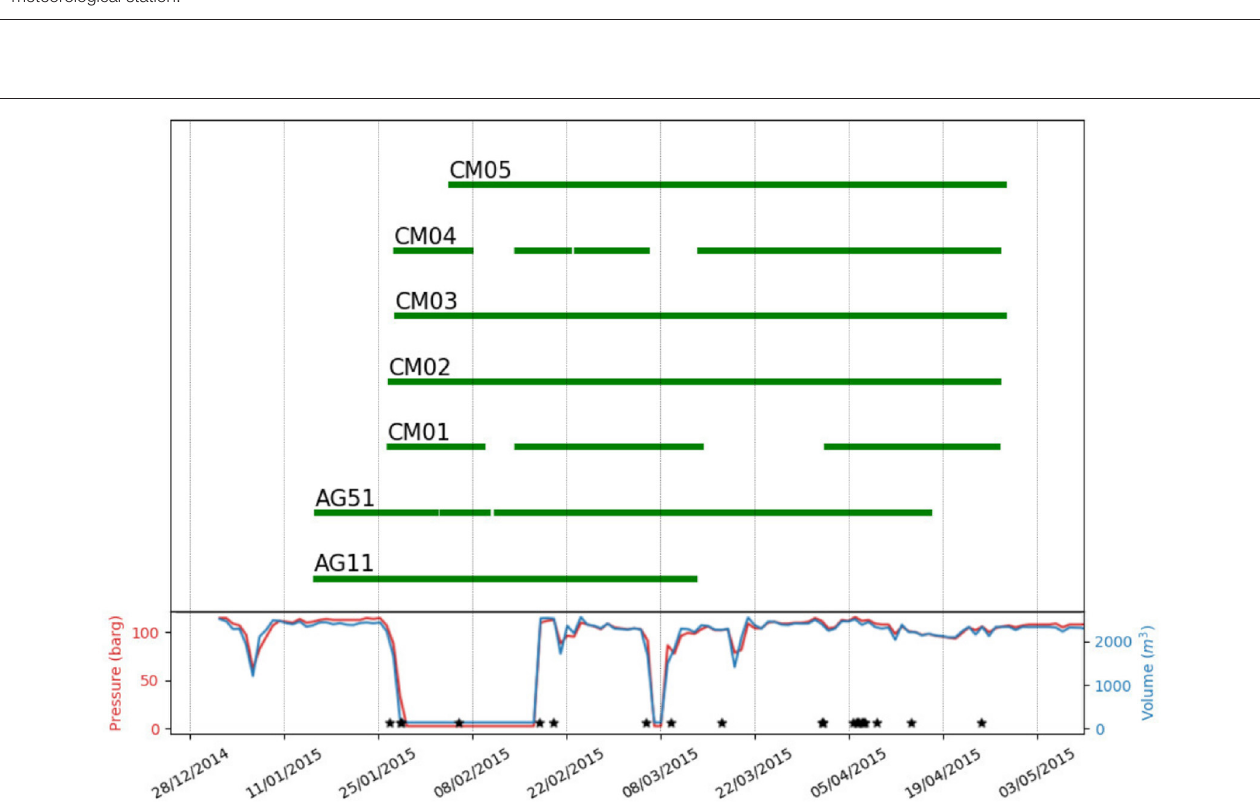
FIGURE 3 | Data availability for each station (top panel) and daily injection data (blue: injection rate; red: maximum wellhead pressure). Black stars indicate the recorded seismicity (25 events with − 0.1 < M L < 0.8).